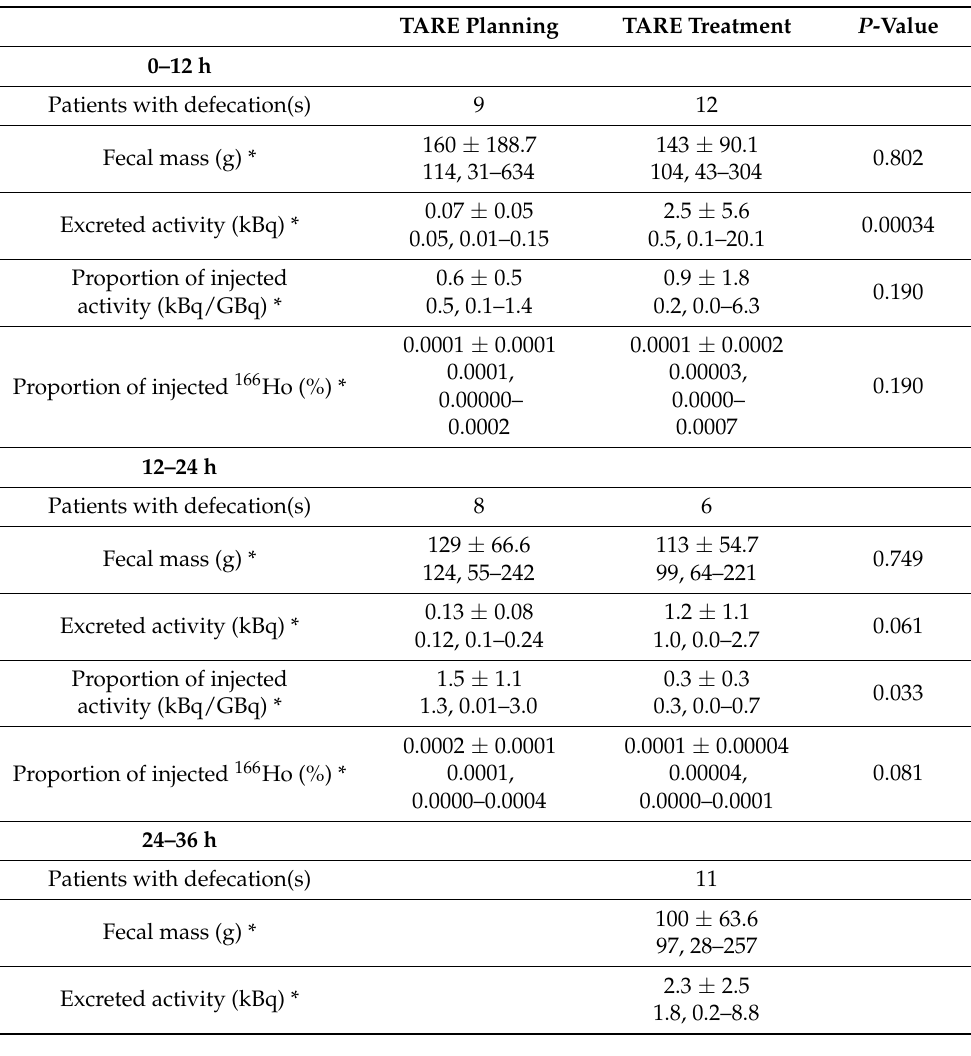
Table 3. Intestinal activity